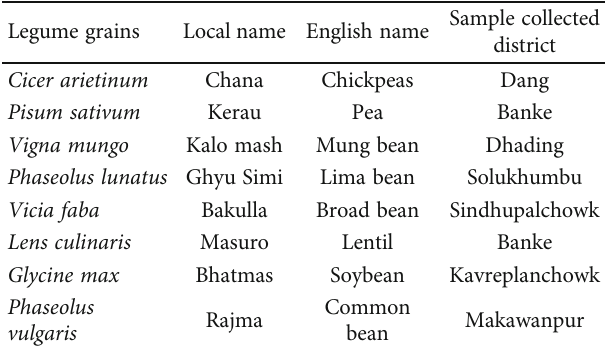
Table 1: The list of legume samples with scienti fi c names, common names, and collected regions. Legume